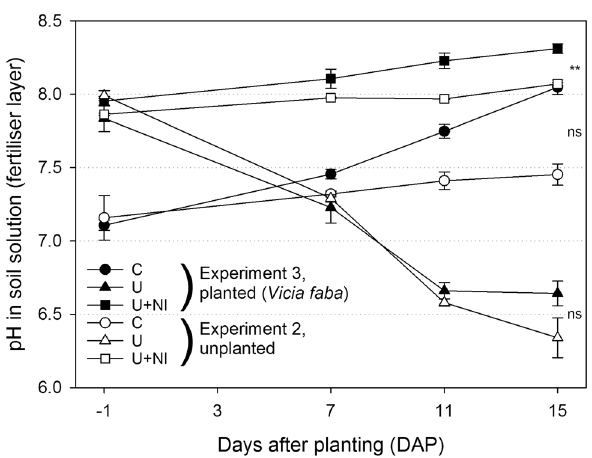
Figure 2. Change of soil solution pH with time in the fertiliser layer in experiments 2 (open symbols) and 3 (filled symbols) for treatments control (“C”, circles), urea (“U”, triangles) and urea with nitrification inhibitor (“U+NI”, squares). First sampling point (-1 DAP) defines starting conditions for root growth in experiment 3. Asterisk indicates significant difference between planted and unplanted treatments at p < 0.01 (**), ns = not significant. Error bars indicate standard